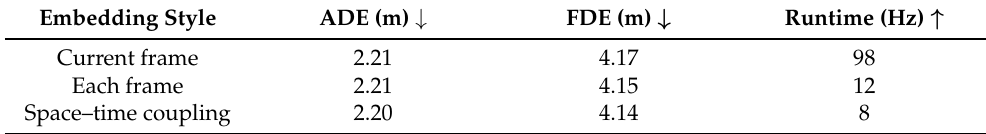
Table 2. Prediction with different embedding methods on the NGSIM